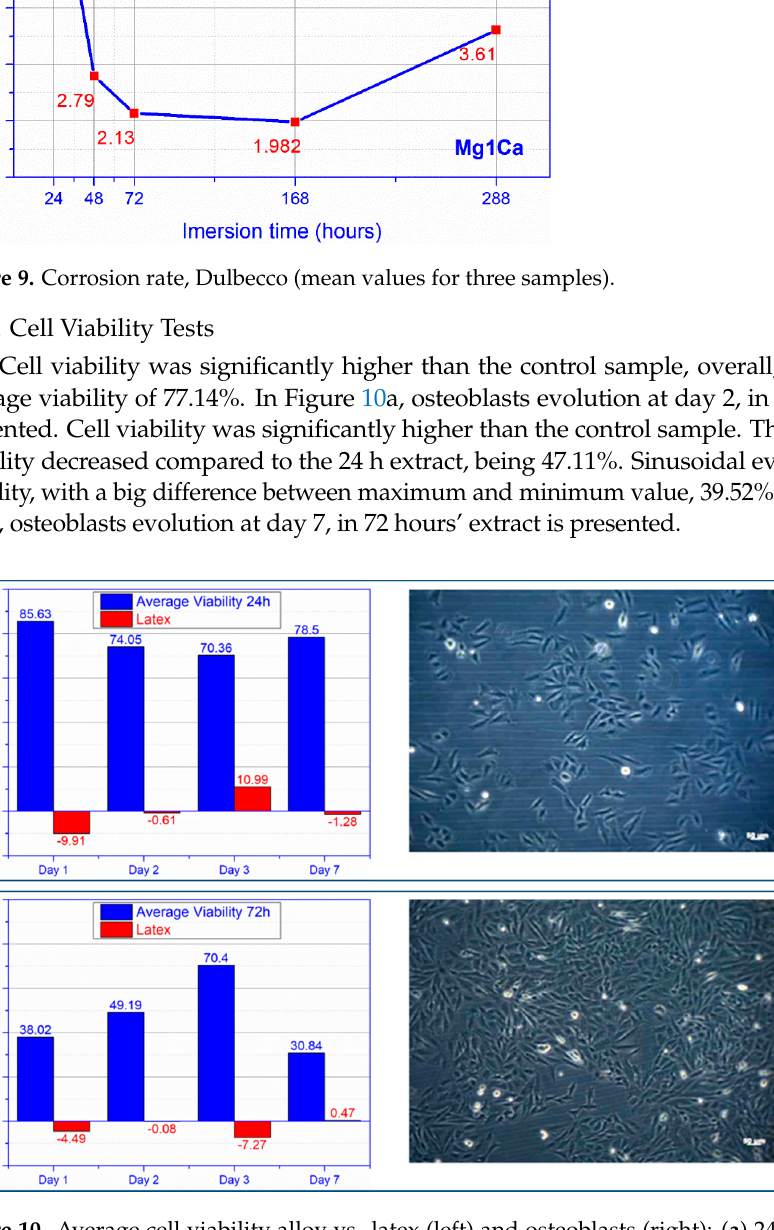
Figure 11. Mg-1Ca SEM image, before immersion. In Figure 12, SEM at 1, 2, 3, 7, and 12 days of immersion in SBF compared to Dulbecco complex medium are presented, and before and after the corrosion products formed on the surface of the alloy were removed. SEM investigations performed on the surface of the Mg-1Ca alloy after testing the corrosion resistance by immersion tests revealed a mor- phology of the surface specific to corrosion, the material showing cracks on the entire tested surface.